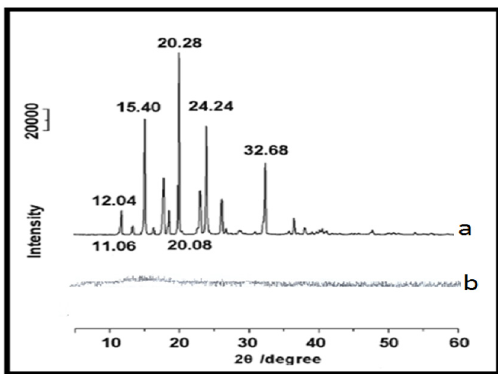
Fig.4. FTIR spectra of (a) NFC, (b) acetaminophen and (c) drug-containing